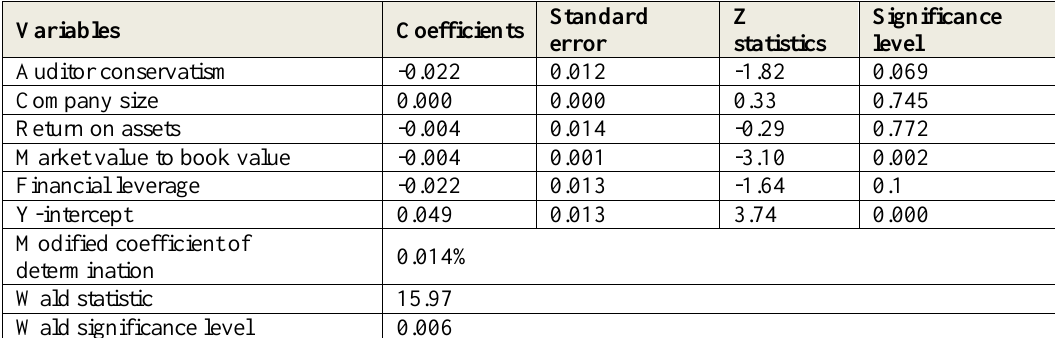
Table 16. Final estimation of the third